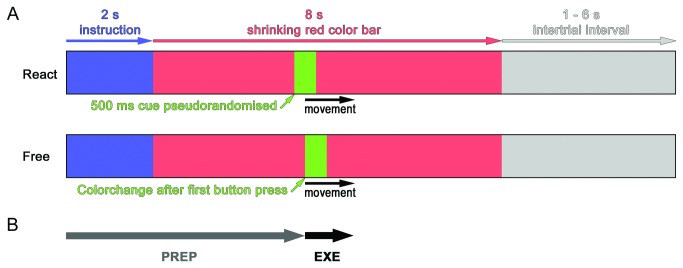
Experimental Paradigm.
A: Experimental paradigm (trial). Black arrow: finger sequence. React-condition (upper bar): movement onset is delayed with respect to the cue (green). Free-condition (lower bar): movement onset triggers color change (green). B: Phases modeled for data analysis: preparation (PREP), execution (EXE).